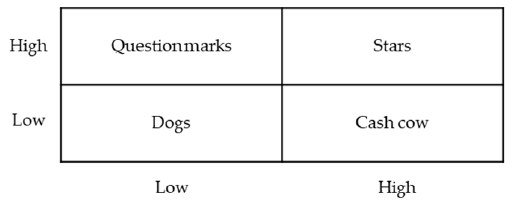
Figure 1. BCG matrix reference modified form [27].